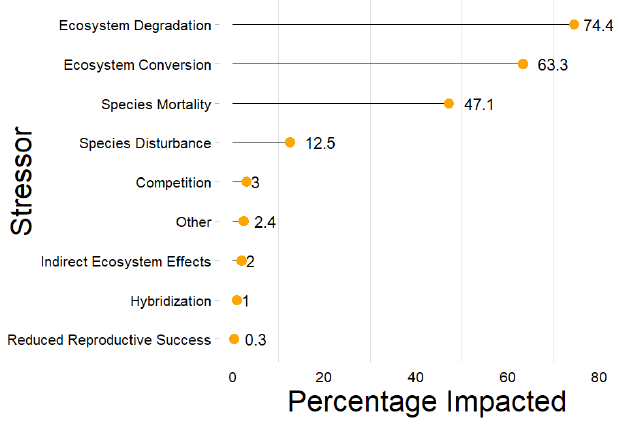
Fig. 6. Percentage of medicinal use animals subject to each stressor. Other stressors were excluded due to negligible